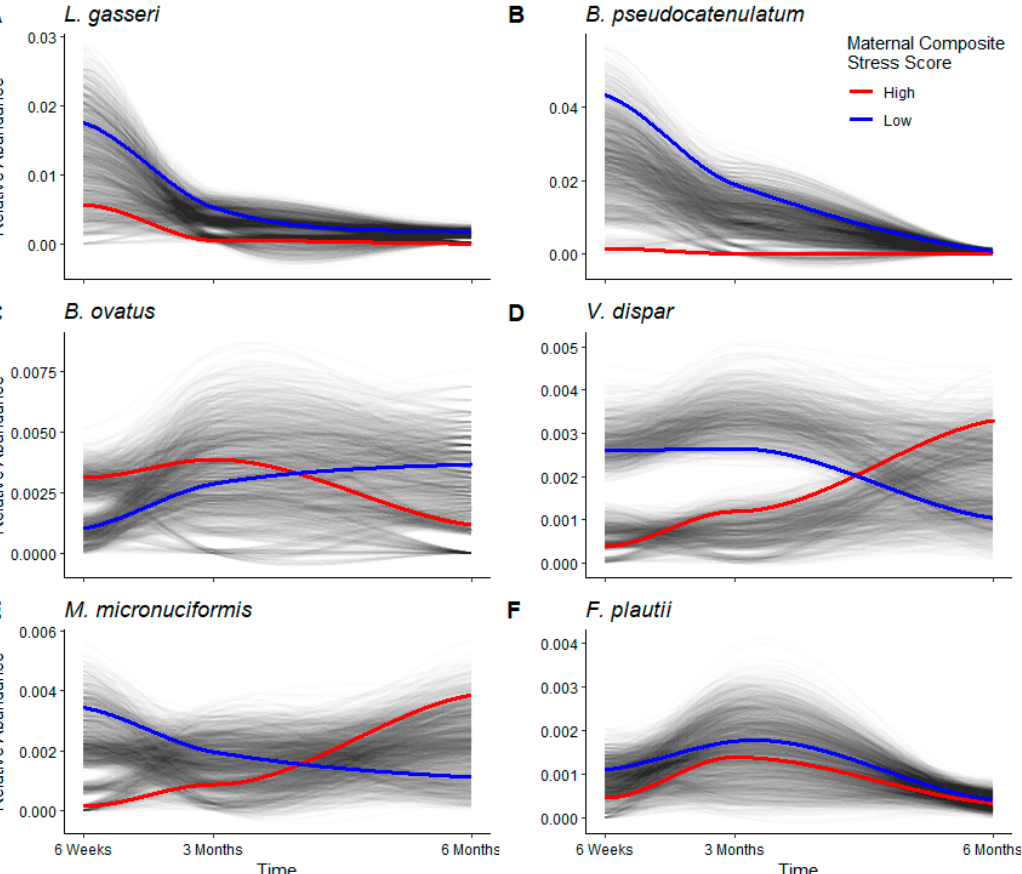
Figure 4. Longitudinal analysis of changes in relative abundance of bacterial species. Relative abundance is plotted on the Y axis, and time is plotted on the X axis. Infants of mothers with high stress (red line) and low stress (blue line) were compared for relative abundance of ( A ) L. gasseri , ( B ) B. pseudocatenulatum , ( C ) B. ovatus, ( D ) V. dispar , ( E ) M. micronuciformis , and ( F ) F. plautii . Note that the scale for relative abundance on the Y axis is an order of magnitude larger in A and B relative to C- F.